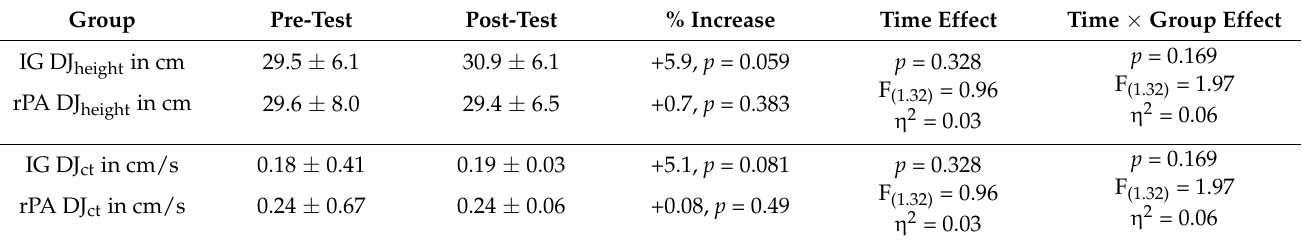
activity group, IG = intervention group.